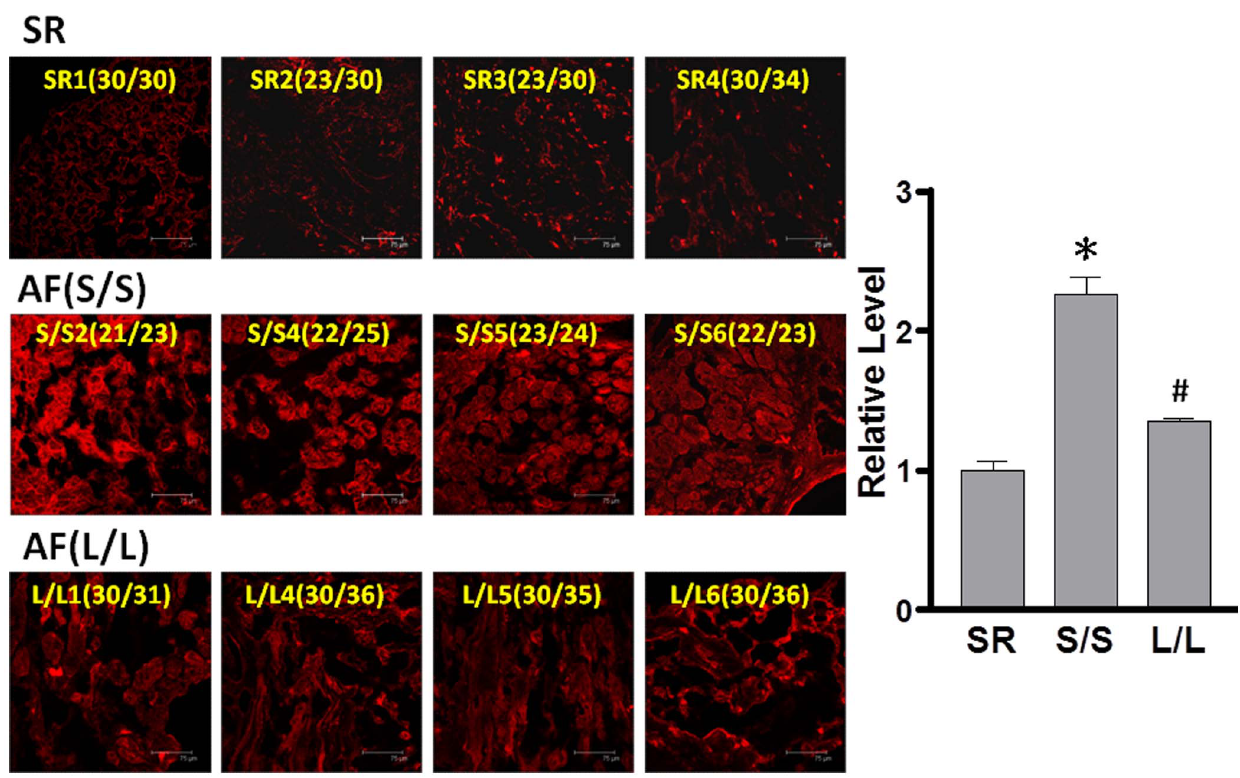
Figure 1. Association of GT-repeat length polymorphism with HO-1 expression in atrial tissues. Representative confocal images show the expression of HO-1 in the atria of 8 AF patients and 4 controls (sinus rhythm subjects [SR], left). The number represents the size of GT-repeats in each subject. Relative intensity of HO-1 measured in the a -actin-expressing areas was quantified (right). S/S denotes 4 of 6 patients with shorter GT- repeat ( , 27 GT) homozygous genotype and L/L denotes 4 of 6 patients with longer ( § 27 GT) homozygous genotype. At least 5 random fields were chosen to observe . 30 myocytes with scanning and averaging. Data are expressed as mean 6 SE. P , 0.05; *, # : the different symbols represent the significant difference among groups.